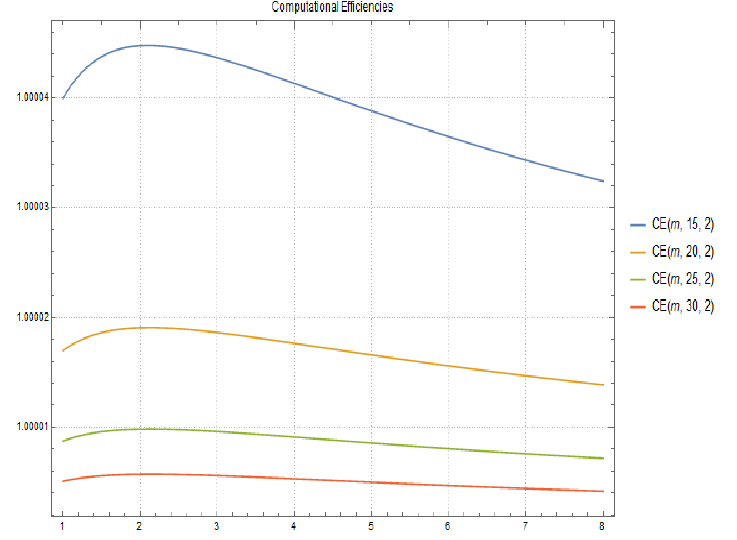
Figure 1. Computational Efficiencies for p = 2 and different values of q and m .